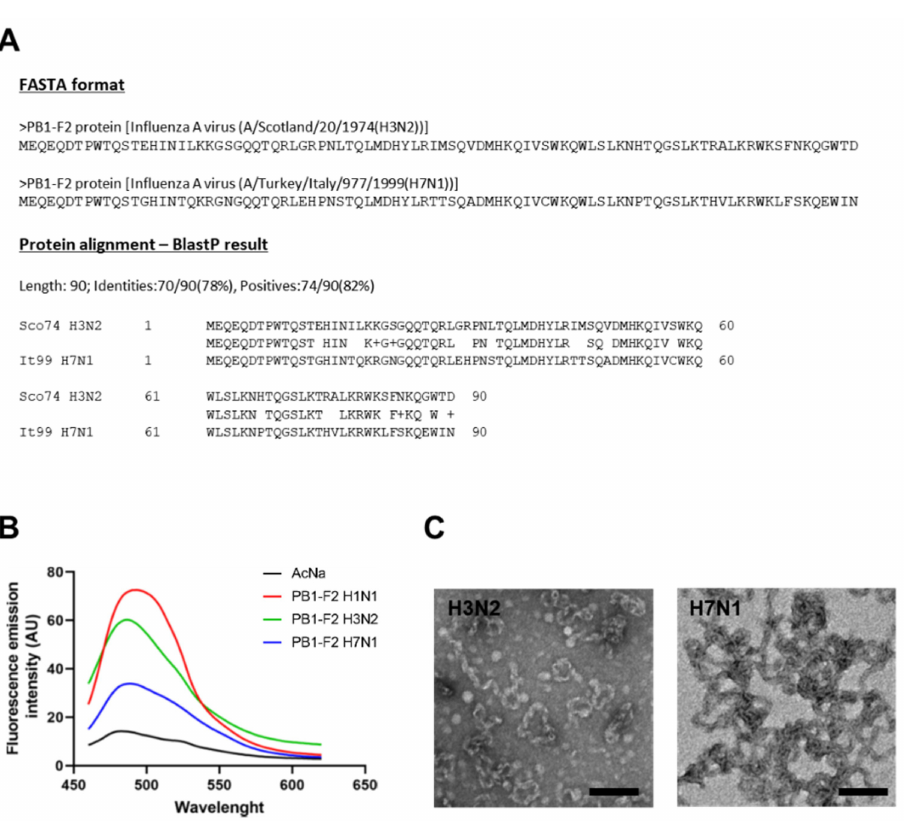
Figure 1. Evaluation of the intrinsic fibrillation capacities of PB1-F2 H3N2 and H7N1. ( A ) Amino acid sequences and protein alignment of the avian and human proteins. ( B ) Measure of the fluorescence increase of ThT after binding with amyloid formed by PB1-F2 H3N2, H7N1 at a final concentration of 10 µ M in 5 mM sodium acetate pH5 buffer at 37 ◦ C. PB1-F2 WSN (H1N1) was used as control of fibrillation. AU, absorbance units. ( C ) Observation by electron microscopy of the fibers formed by H3N2 (left) and H7N1 (right) PB1-F2 variants in 10 mM sodium acetate, pH 5 at 37 ◦ C. Scale bars, 1 µ m. In the presence of fibers formed by PB1-F2 from H3N2 and H7N1 viruses, the